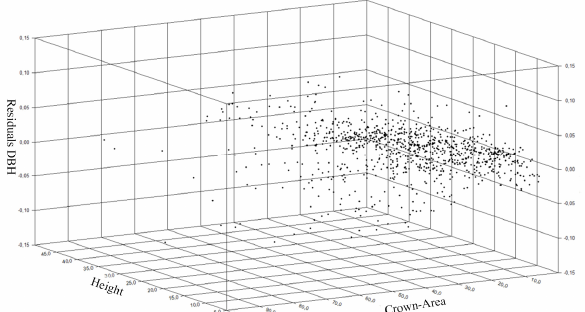
Figure 4. Graph of the generated function The residual graph for the generated function (Figure 5) also shows only a small difference between the calculated and the measured DBH.